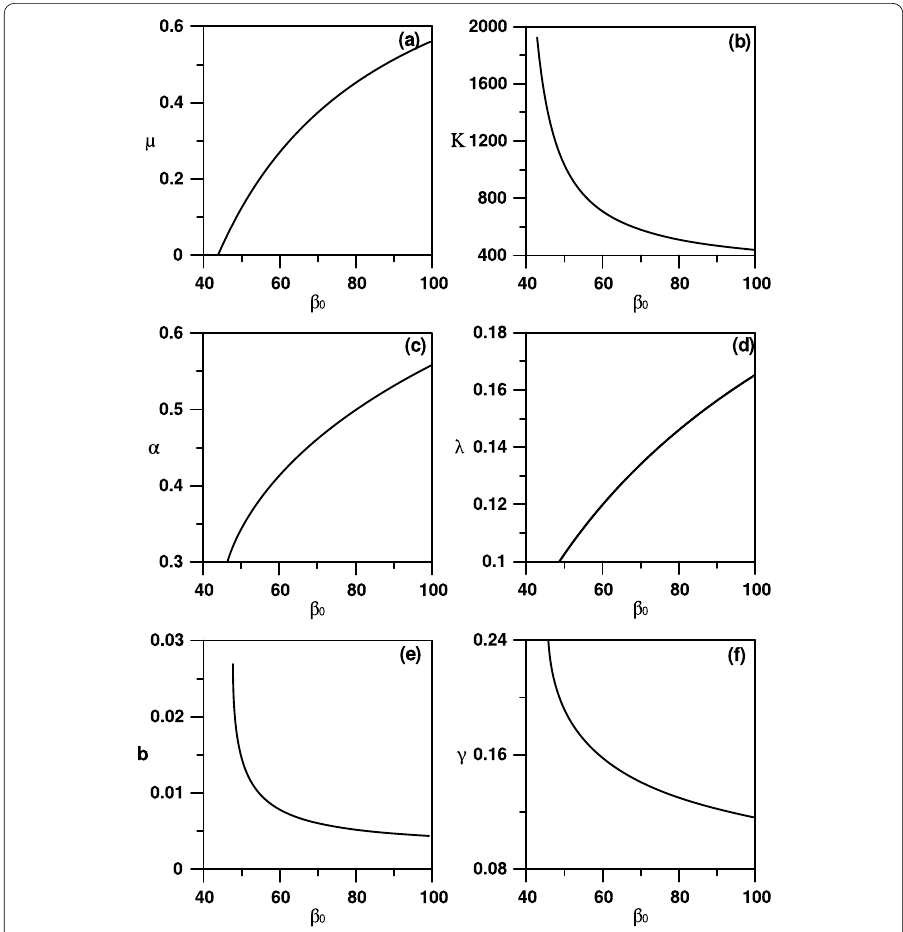
Figure 3 Two parameter continuity diagrams showing the locus of the Hopf point of Fig. 1